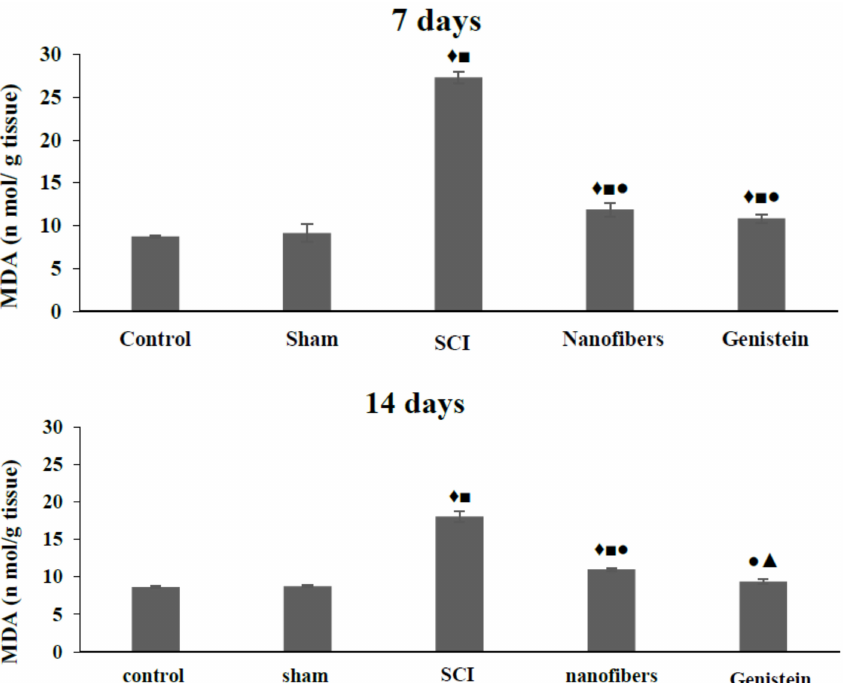
Figure 3. Mean concentration of Malondialdehyde (MDA) (n mol/g tissue) in spinal cord tissue. Spinal cord injury leads to significant ( (cid:7) , (cid:4) , p < 0.05) elevation of MDA levels at all time points. Implantation